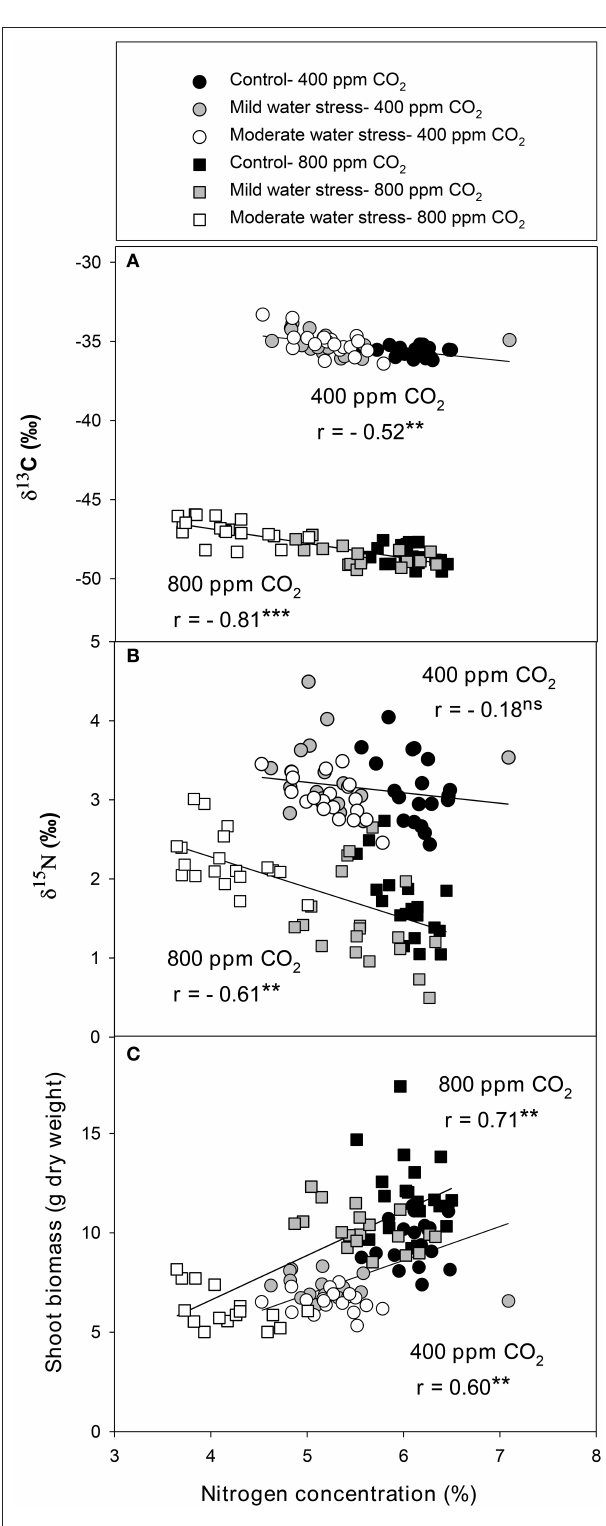
FIGURE 2 | Relationships of leaf nitrogen concentration with the stable isotope compositions of (A) carbon ( δ 13 C) and (B) nitrogen ( δ 15 N) and the (C) shoot biomass of sweet pepper grown hydroponically under different [CO 2 ] and water regimes. Levels of significance: ** P < 0.01 and *** P < 0.001.